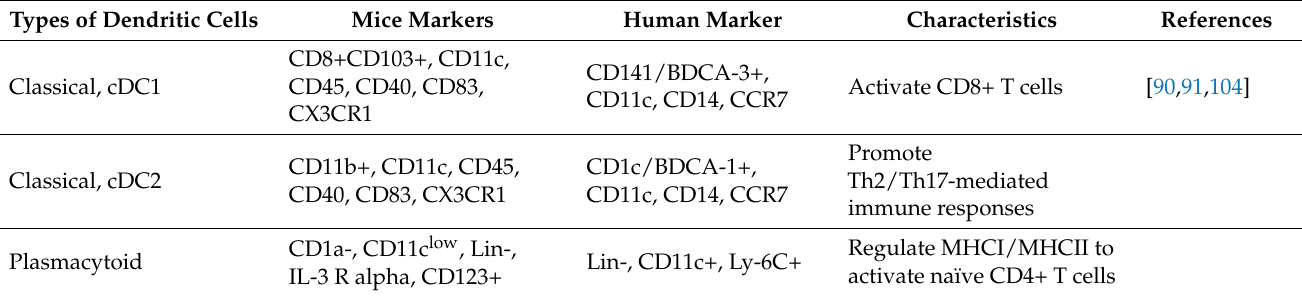
Table 5. Dendritic cells and